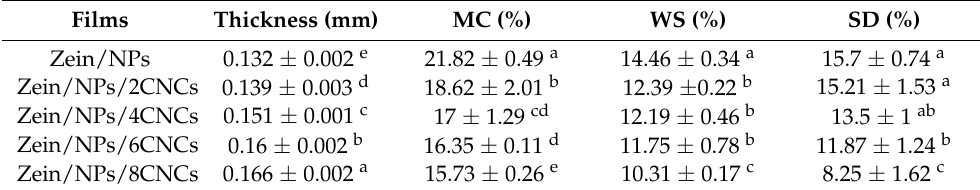
Table 1. Thickness, MC, WS and SD of zein films.